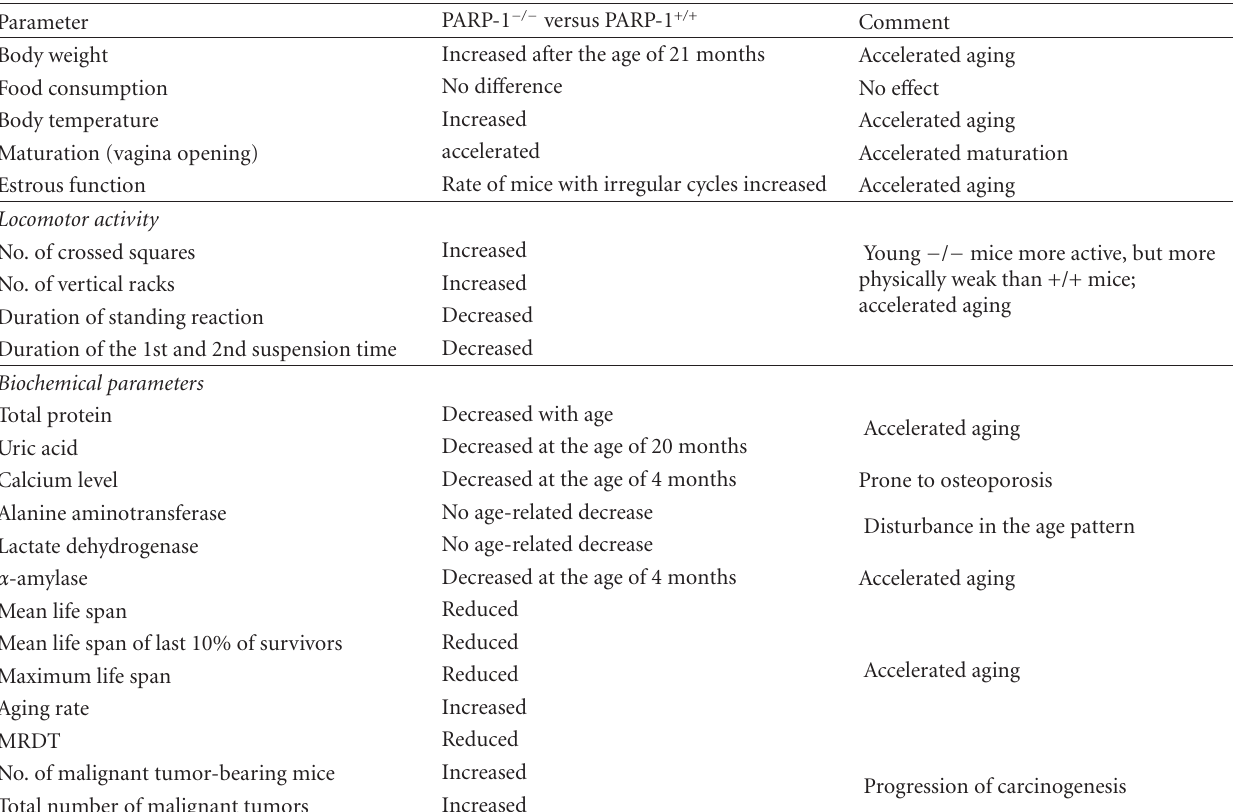
Table 8: E ff ects of PARP-1 knockout in female